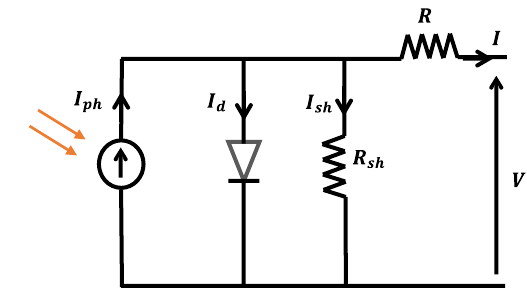
Fig. 2 PV panel equivalent circuit